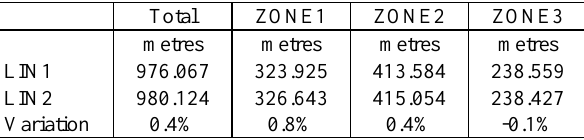
Table 1. 3D Lengths of LIN1 and LIN2